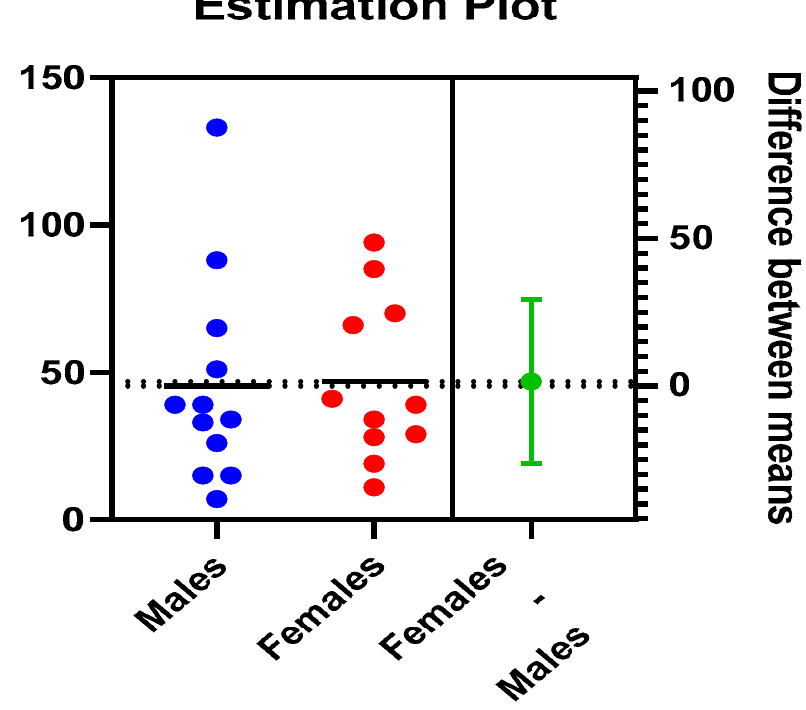
Figure 1. Gender and age distribution in nephroblastoma.